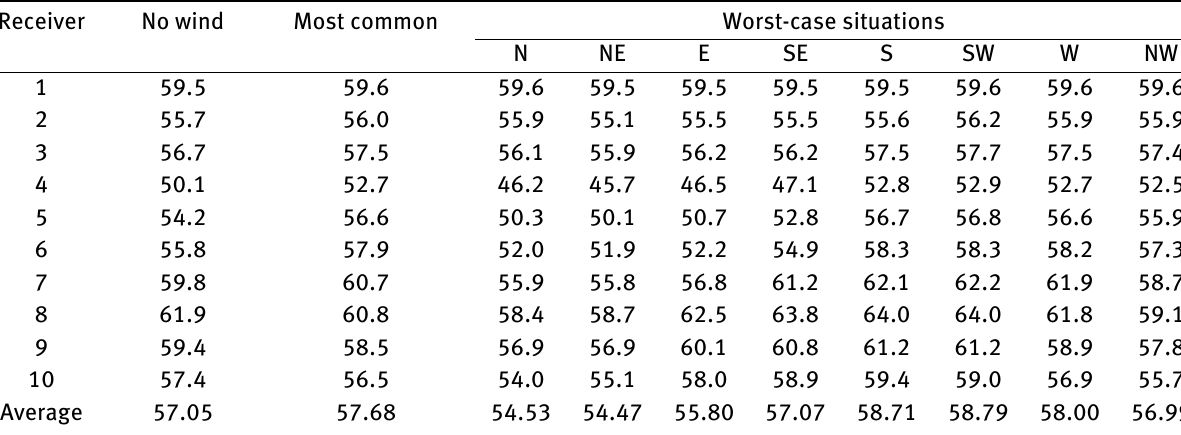
Table 2: Noise levels (LDEN) for different scenarios based on wind speed and direction